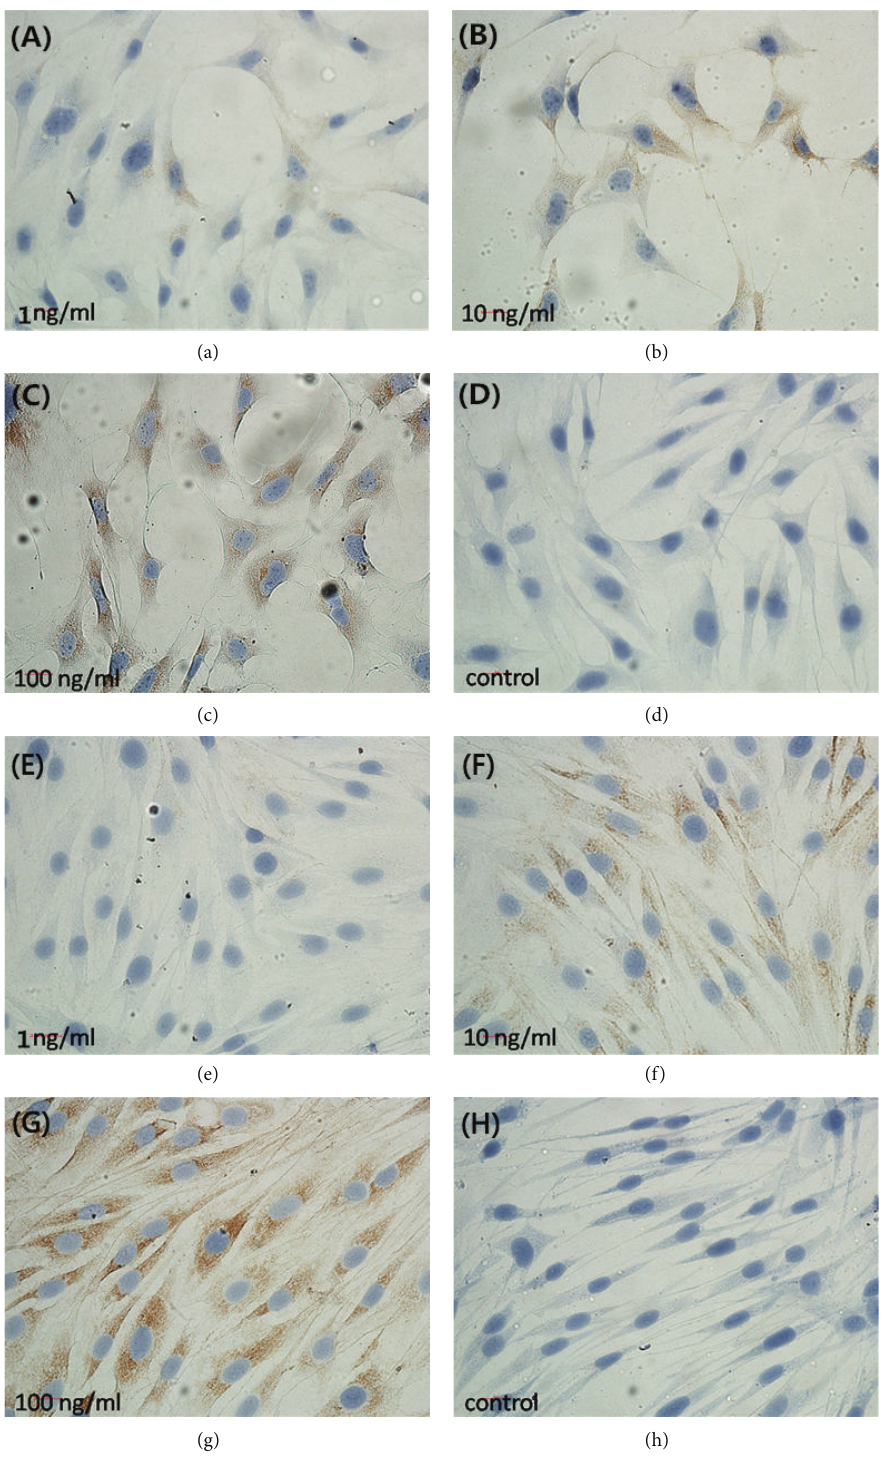
Figure 2: Immunohistochemical results of OPG expression in OCCM-30 and MC3T3-E1 cells with TGF- 𝛽 1 treatment.